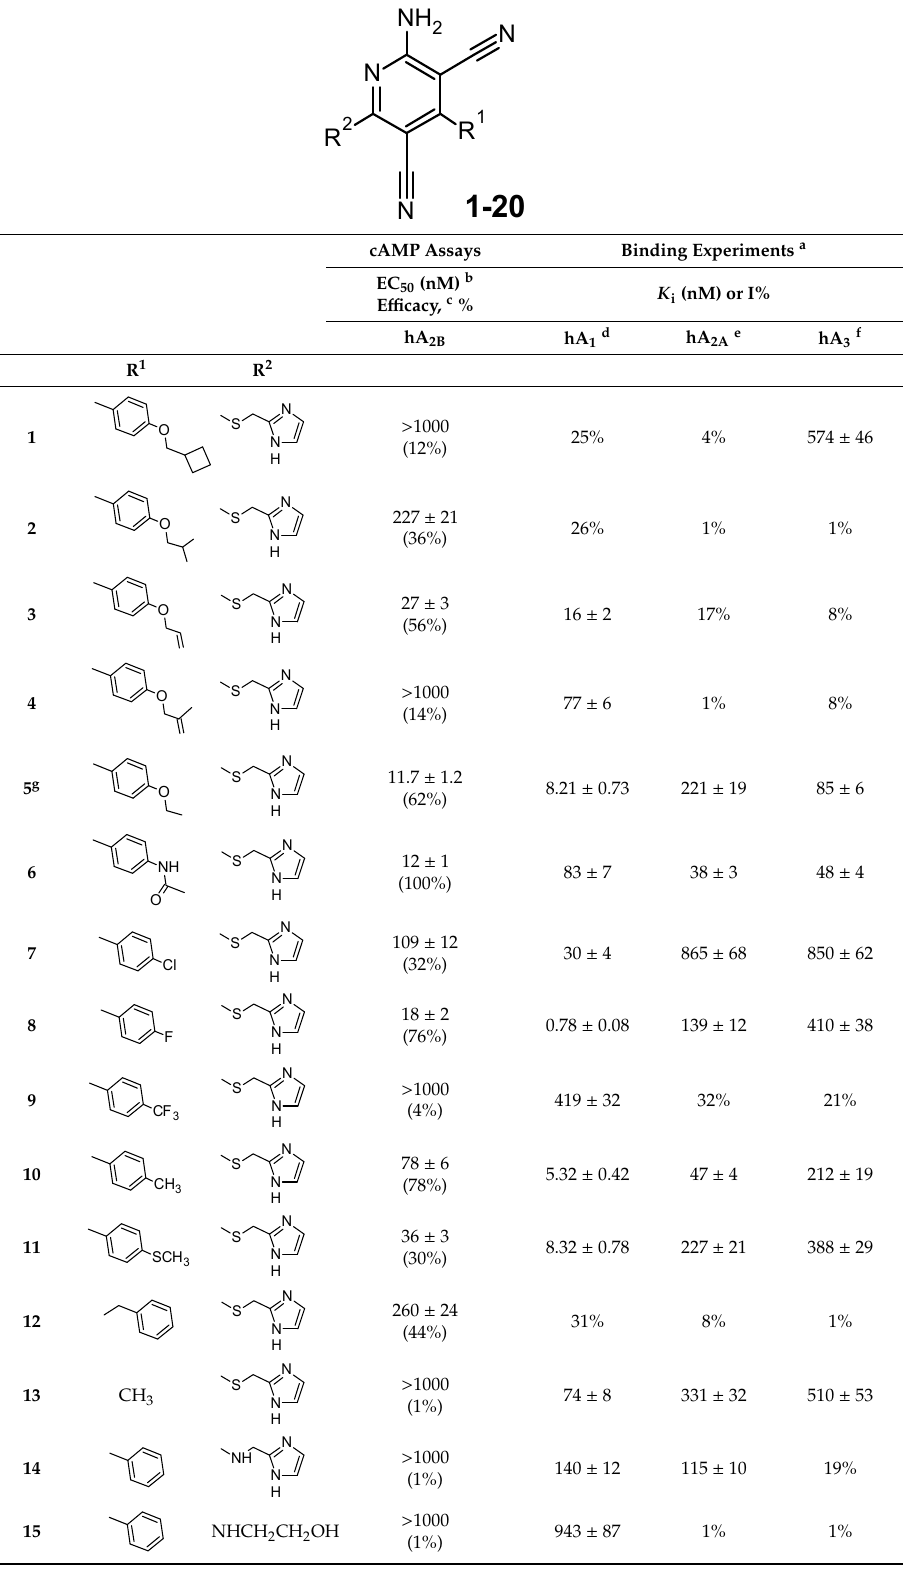
Table 1. Binding affinities ( K i ) at hA 1 , hA 2A , and hA 3 ARs and potencies (EC 50 ) at hA 2B ARs.